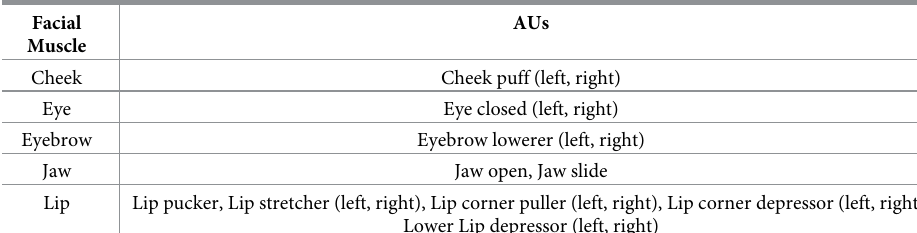
Table 1. Kinect v2 face tracking SDK action